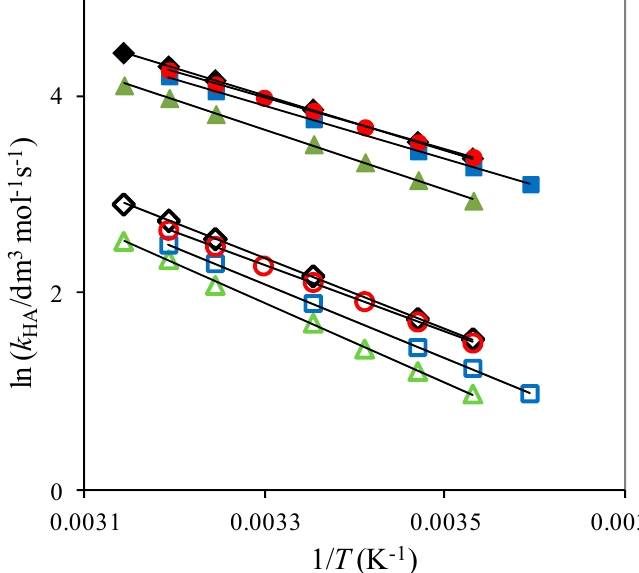
Figure 2. Arrhenius plot on the reaction of ascorbate and hexacyanoferrate(III) ion in different organic cosolvent—H 2 O (filled symbols) and organic cosolvent—D 2 O mixtures (hollow symbols). Key: black diamond, 1,4-diox:water = 0.05:0.95 v / v ; green triangle, 1,4-diox:water = 0.10:0.90 v / v ; blue square, MeCN:water = 0.10:0.90 v / v ; red circle, EtOH:water = 0.10:0.90 v / v . Abbreviations as noted in Table 1.